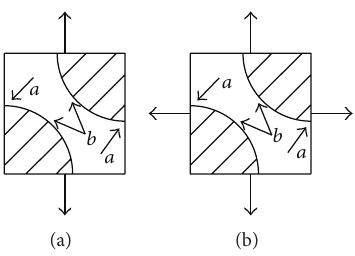
Figure 8: Stress concentration areas in uniaxial and biaxial tension load cases—orientation 2.